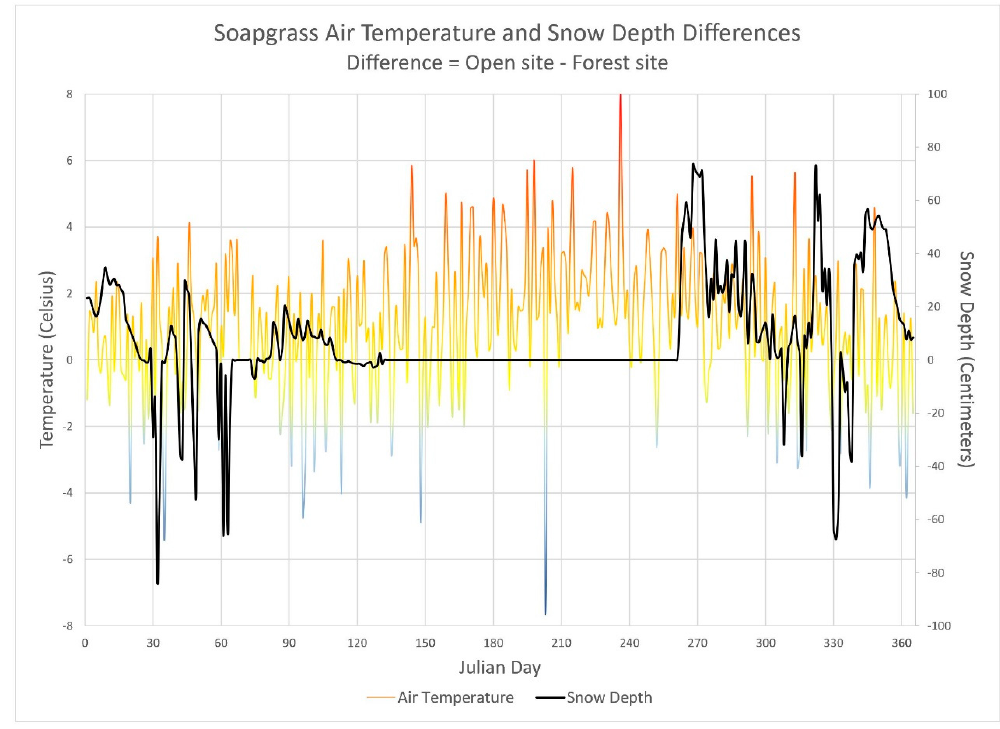
Figure 2. Daily air temperature (°C) and snow depth (cm) for both the forest and open sites at the Soapgrass station. A positive air temperature difference means the open site was warmer than the forest site. A positive depth difference means the open site had more snow than the forest site.